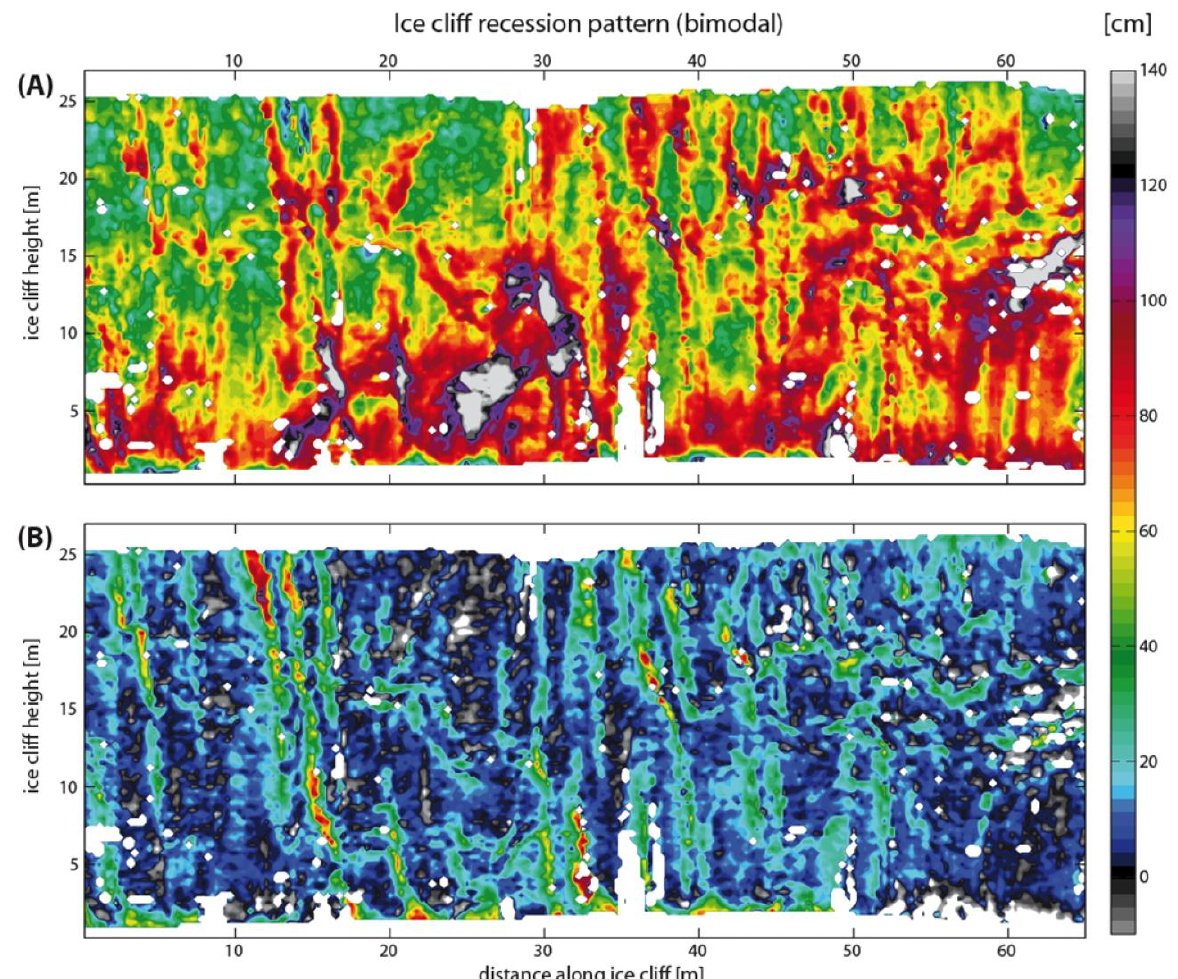
Figure 3: Ice cliff recession at the sample cliff in centimeters: (A) during the “sunlit phase” (ca. October 12 to March 3) with a mean recession of 15 cm/month, (B) during the “shaded phase” (rest of the year) with a mean rate of 2 cm/month. The resolution in width and height is 25 cm. The precision of the method is given in the